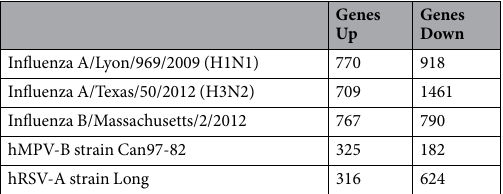
Table 1. Number of differentially over- or under-expressed genes compared to mock. Differential expression was calculated by comparing each condition to the mock using a linear model. The Holm procedure was used to control the false discovery rate. Genes with an absolute fold change > 2 and a corrected p-value < 0.05 were considered as differentially